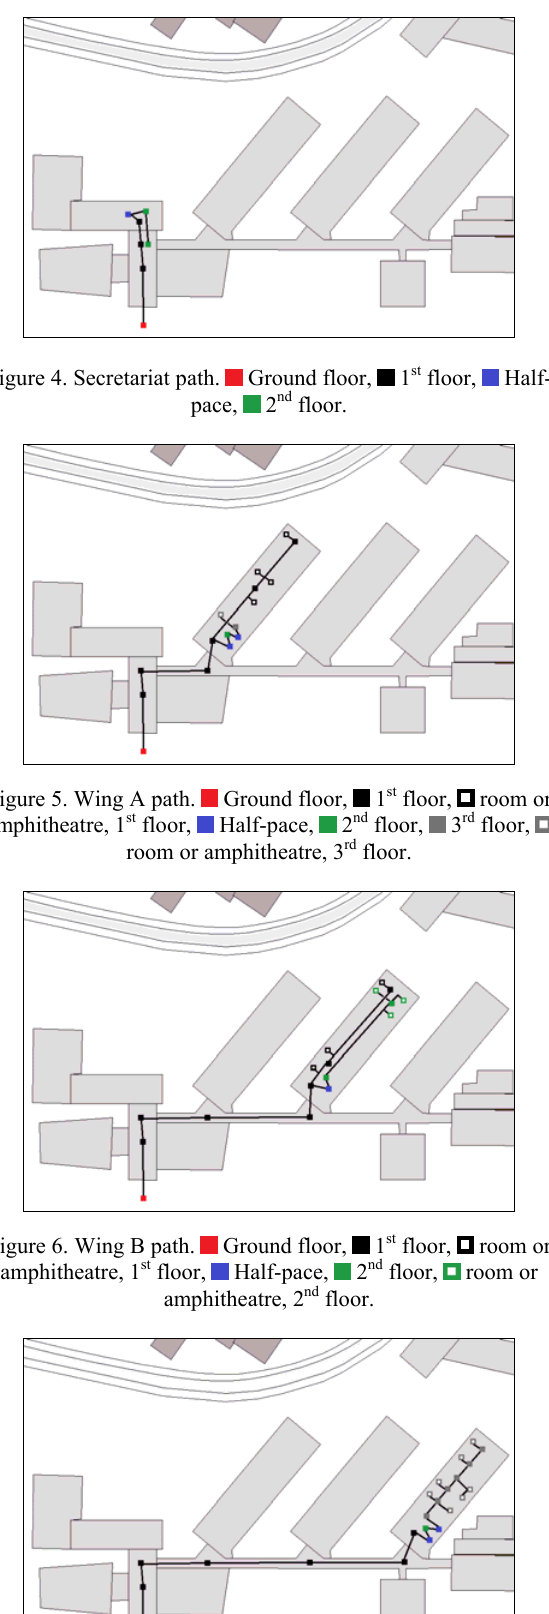
Figure 7. Wing C